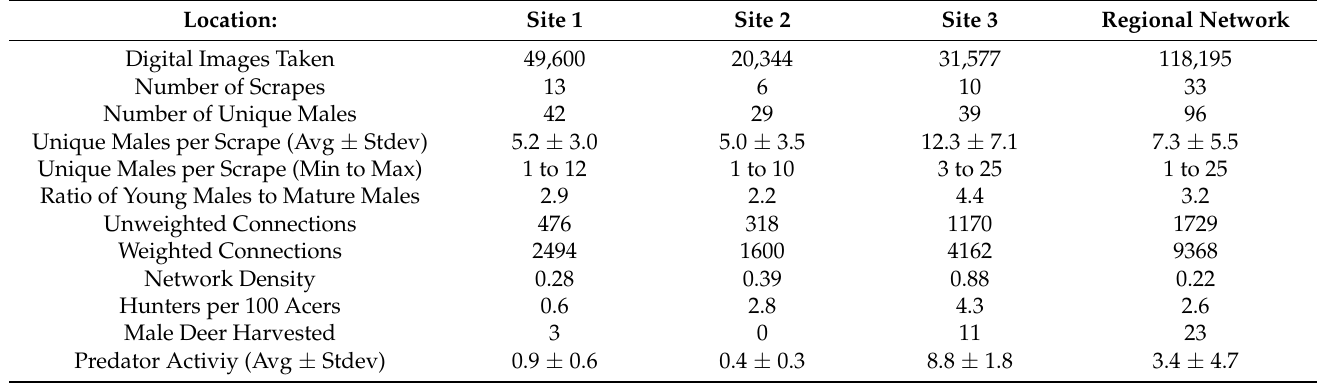
Table 2. Site Specific Data and Network Statistics. The table shows data collected at Site 1, Site 2, Site 3, and over the entire Regional Network. Shown are the number of images taken, number of scrapes surveyed, number of unique males at each site, Avg ± Stdev of unique males per scrape, min to max of unique males per scrape, ratio of young to mature males, hunters per 100 acers, number of male WTD harvested, and Avg ± Stdev of predator activity (counts per week). Shown are the network statistics calculated for Site 1, Site 2, Site 3, and over the entire regional network. Shown are the weighted and unweighted connections, and network